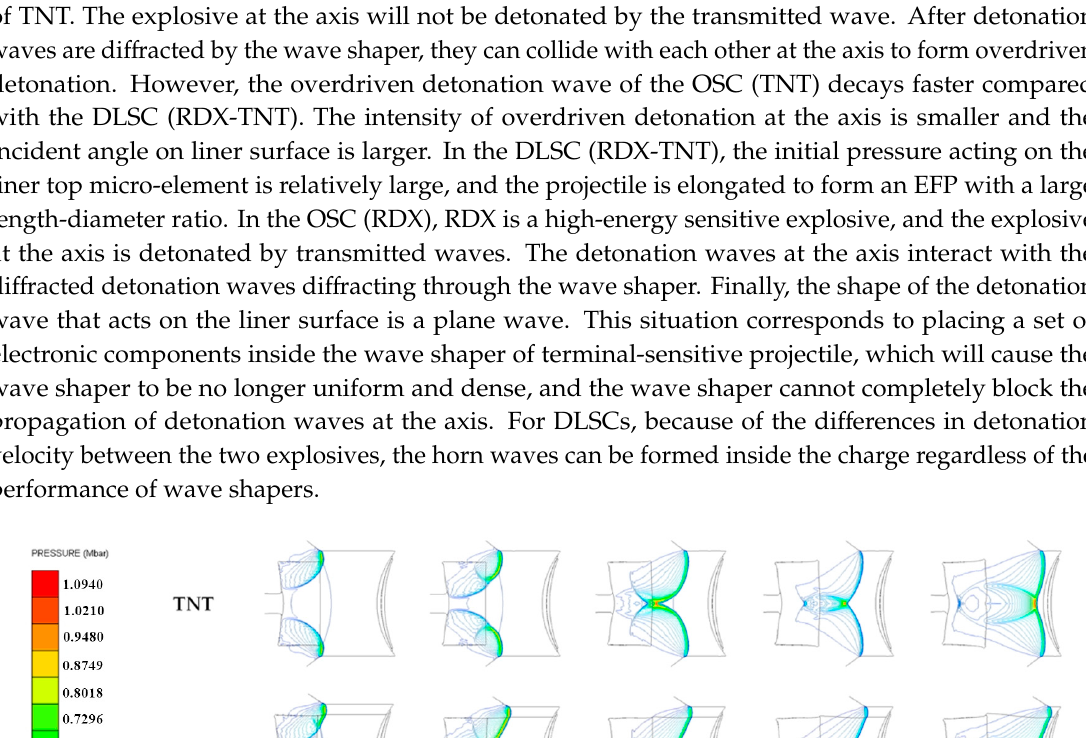
Figure 6. Compositions of three shaped charges: OSC (TNT), DLSC (8701-TNT) and OSC (8701). The penetration ability of EFP is verified by experiments, and the blasting height is 500 mm. The target of EFP penetration is initially set as a two-layer 4340 steel ingot with a diameter of 160 mm and a thickness of 70 mm + 30 mm. During the experimental of the OSC (8701), because the diameter of the prepared 4340 steel ingot was too small, the steel ingot was cracked after penetration. In the subsequent experiments of DLSC (8701-TNT) and OSC (TNT), the penetration target was replaced with a rolled homogeneous armour (RHA) target with a thickness of 80 mm. The main parameters of RHA are as follows: density 𝜌 = 7.86 𝑔/𝑐𝑚 (cid:2871) , shear modulus 𝐺 = 64.1 𝐺𝑃𝑎 , and yield stress 𝑌 (cid:3046) = 1.5 𝐺𝑃𝑎 . The experimental layout is shown in Figure 7.